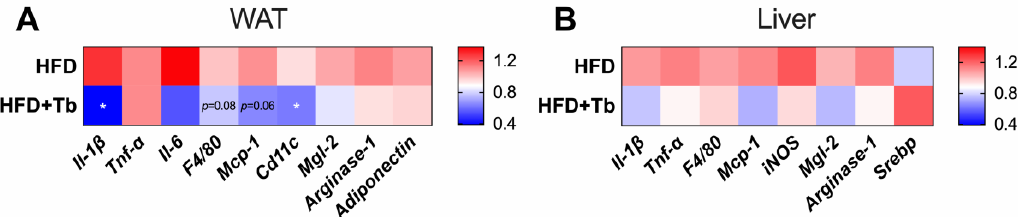
Figure 4. Tributyrin treatment reduced the expression of inflammatory markers. ( A ) mRNA expression of inflammatory markers, arginase-1 and adiponectin in the epididymal white adipose tissue (eWAT) ( n = 6–9 mice/group) . ( B ) mRNA expression of inflammatory markers, arginase-1 and Srebp in the liver ( n = 5–9 mice per group). Data are presented as mean ± SD. * p < 0.05 HFD vs. HFD+Tb, Student’s t- test.